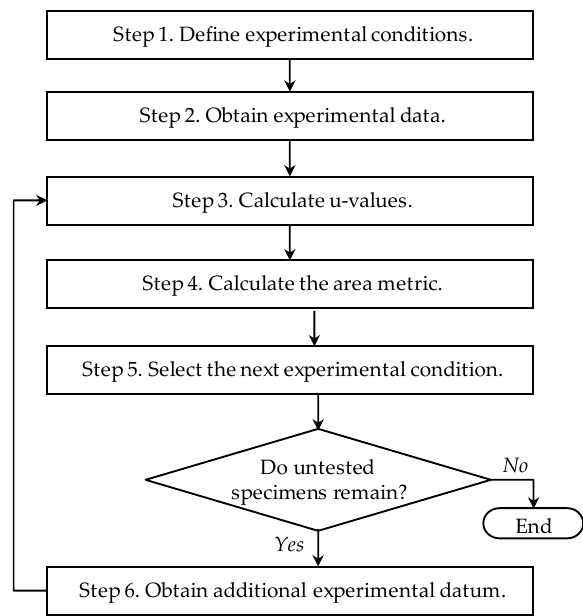
Figure 3. Flow diagram of the proposed response-adaptive experiment design method.